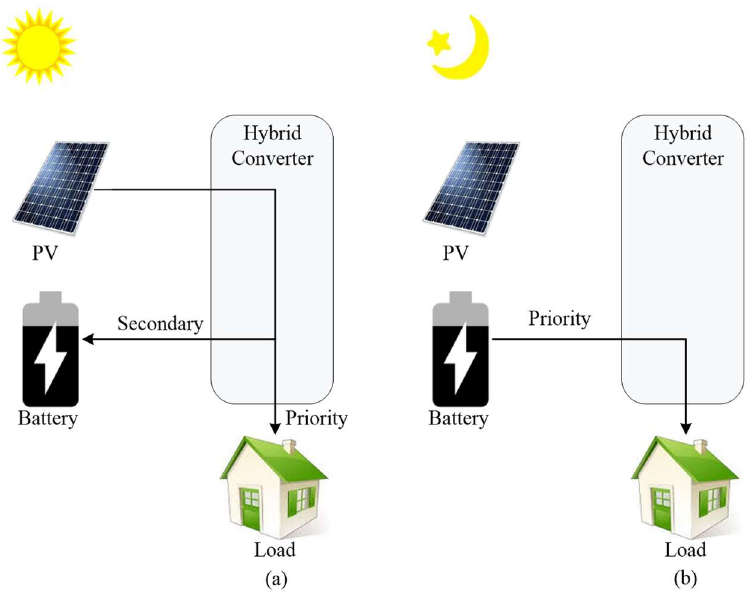
Figure 4. Off-grid mode: PV power is sufficient ( a ), PV power is insufficient ( b ).